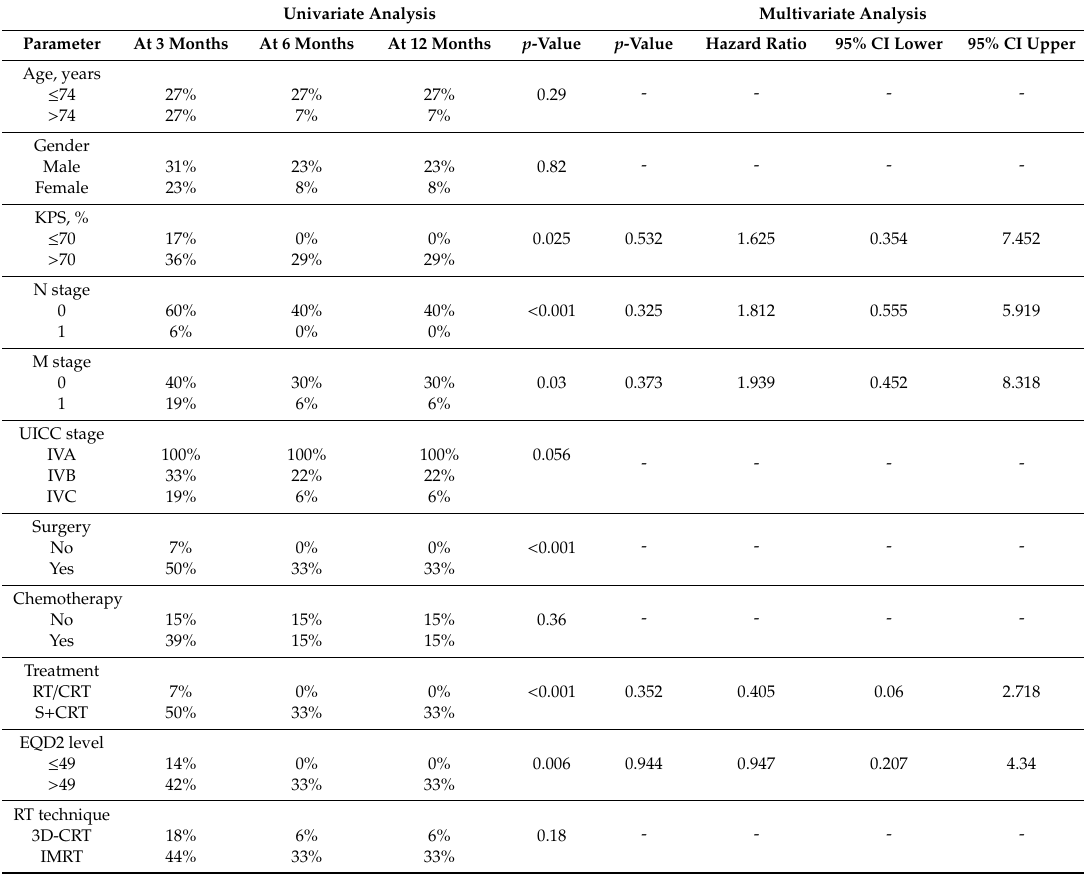
Table 7. Uni- and multivariate analysis of progression-free survival